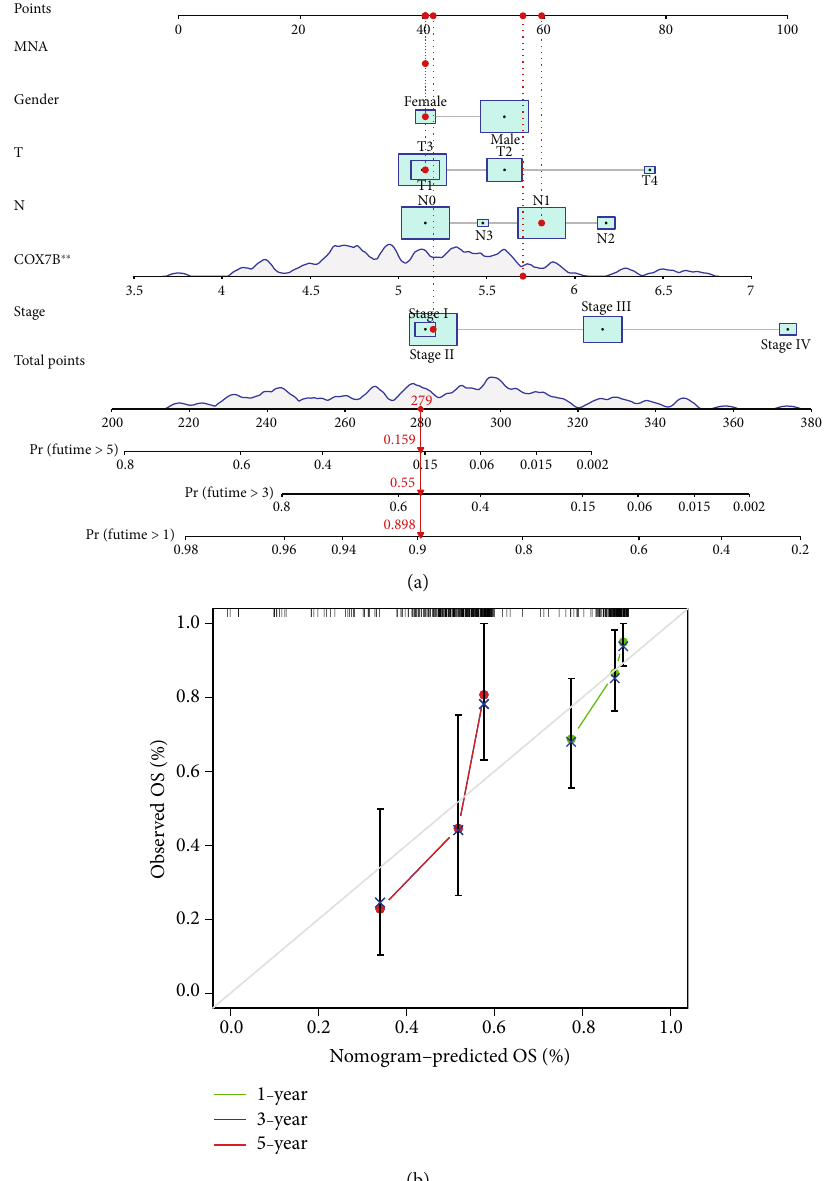
Figure 5: (a) Survival nomogram for estimating the likelihood of survival for ESCA patients over the course of 1, 3, and 5 years. (b) An ideal nomogram is represented by the diagonal dashed line in the calibration curve for the overall survival